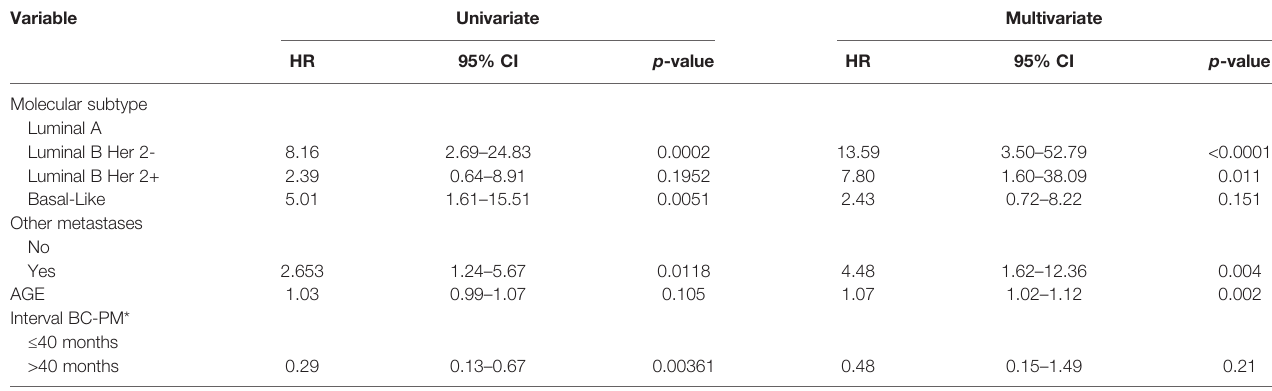
TABLE 4 | Prognostic factors in fl uencing survival: univariate and multivariate analysis in the 49 patients with peritoneal metastases from breast cancer. Variable